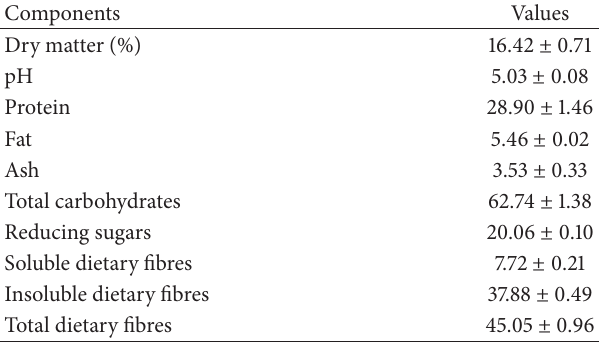
Table 2:Chemical composition of Agave leaves (g/100g drymatter). Table 3: Mineral composition of Agave leaves.